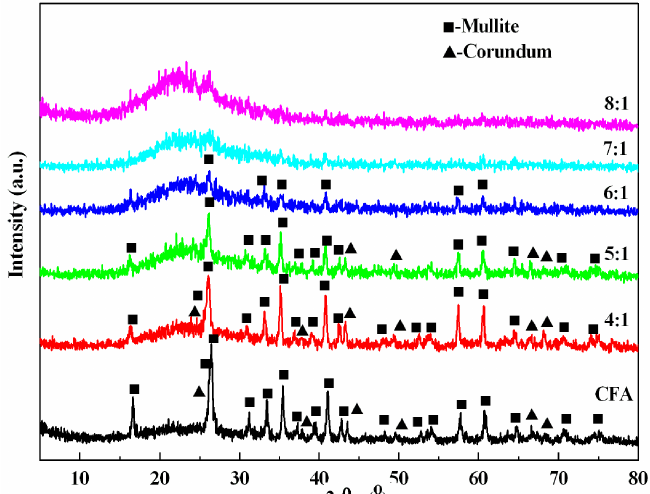
Figure 8. XRD spectra of CFA and residue at different KHSO 4 /Al 2 O 3 molar ratios.